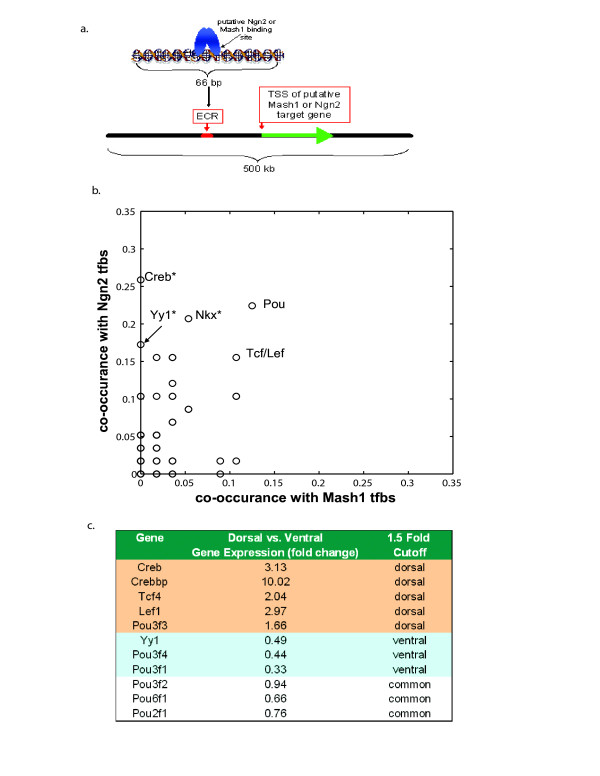
Identification of potential co-factors for Ngn2 and Mash1 using bioinformatics approaches in comparative genomics. (a) Putative Ngn2 and Mash1 bindings sites were identified in ECRs in a 500 kb region surrounding 34 Ngn2 and Mash1 target genes (list of target genes analyzed in Additional file 8). Other TFBSs were identified within 30 bp of the putative Ngn2 or Mash1 binding site. (b) TRANSFAC TFBSs that co-occurred with Ngn2 binding sites versus Mash1 binding sites surrounding Ngn2 target genes versus Mash 1 and common target genes, respectively. A total of 58 Ngn2 sites and 56 Mash1 binding sites were analyzed. A * denotes significantly enriched TFBSs in the sequence surrounding Ngn2 sites versus Mash1 sites (Fisher's exact two-sided test with p ≤ 0.05). (c) Comparison of microarray gene expression values of potential Ngn2 and Mash1 co-factors in wild-type dorsal and ventral telencephalon tissues where column three presents results using a 1.5-fold change cut-off value for categorizing gene expression as either preferentially dorsal, ventral, or both (common).